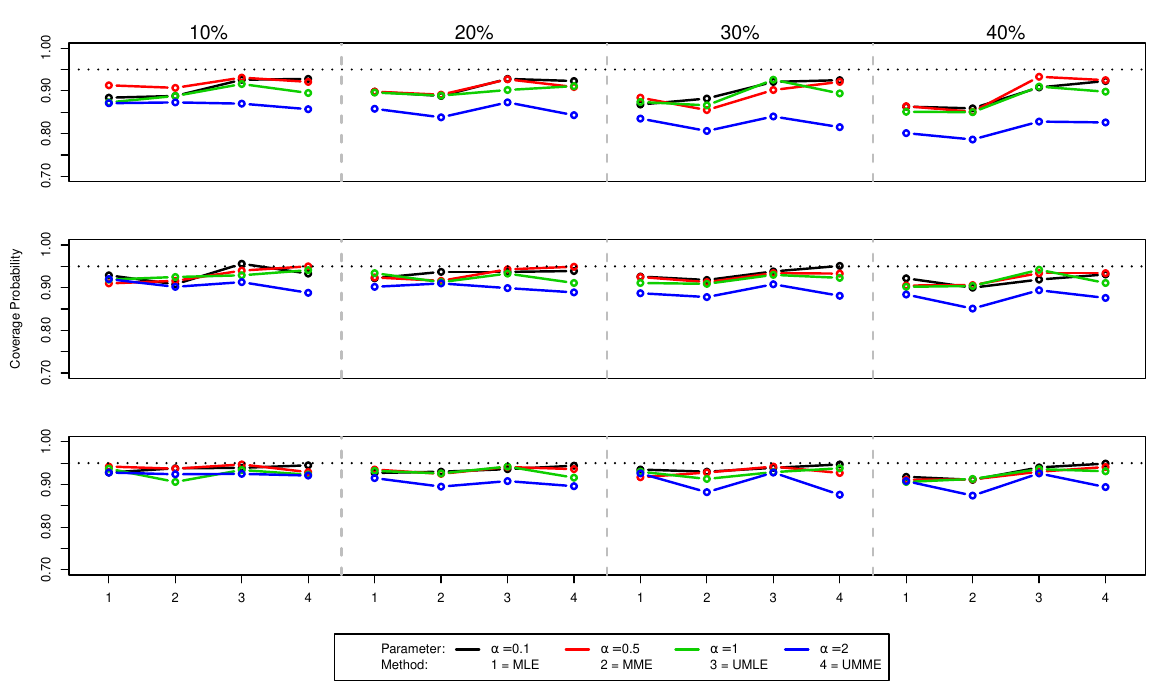
Figure 4. Coverage probabilities of β values for n = 10 ( top panel), n = 20 ( middle panel), and n = 30 ( bottom panel) for various censoring percentages. Dotted black line indicates the nominal 95% confidence